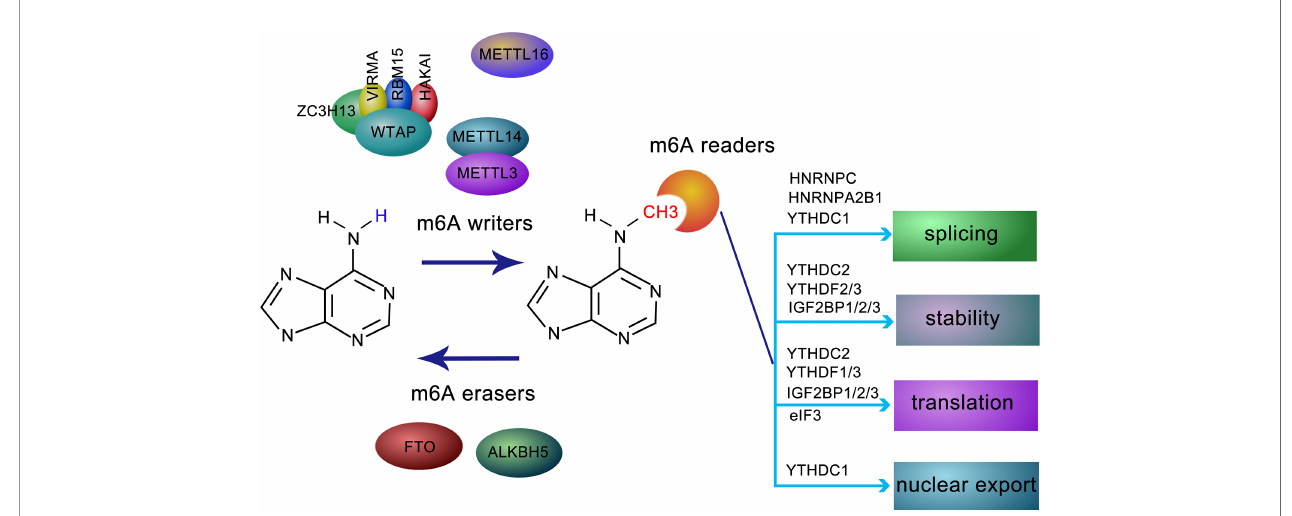
FIGURE 1 | Molecular composition and regulation mechanism of m6A methylation modi fi cation. m6A methylation is a dynamic and reversible process coordinated by methyltransferases (de fi ned as “ writers ” , including METTL3, METTL14, WTAP, ZC3H13, HAKAI, VIRMA, and RBM15), demethylases (de fi ned as “ erasers ” , FTO and ALKBH5), and “ readers ” , such as YTHDF1-3, YTHDC1, IGF2BPs, HNRNPC, HNRNPA2B1, and eIF3, recognize and bind to m6A-modi fi ed RN and mediating RNA splicing, stability, translation, and RNA nuclear